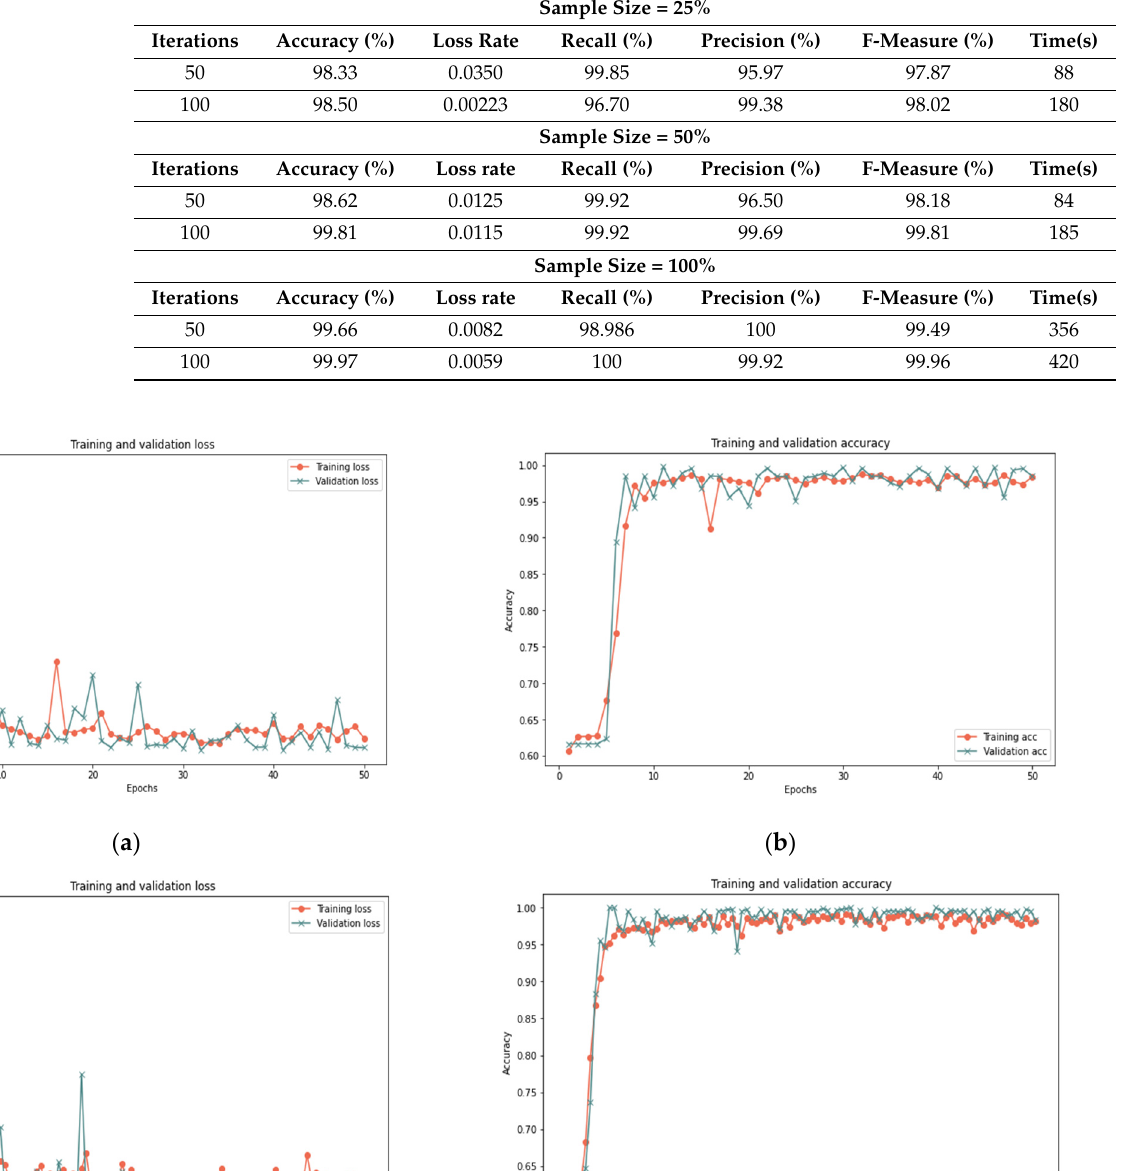
( d ) Figure 10. Results of the 50% sample size: ( a ) loss of 50 iterations, ( b ) accuracy of 50 iterations, ( c ) loss of 100 iterations, ( d ) accuracy of 100 iterations.